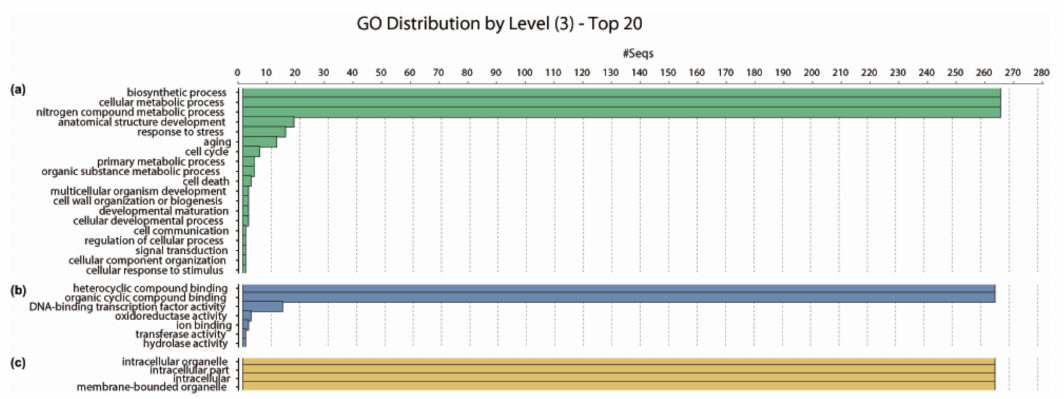
Figure 4. GO (gene ontology) annotation of Populus NAC genes. GO analysis of 289 Populus NAC genes sequences predicted for their involvement in biological processes ( a ), molecular functions ( b ) and cellular components ( c